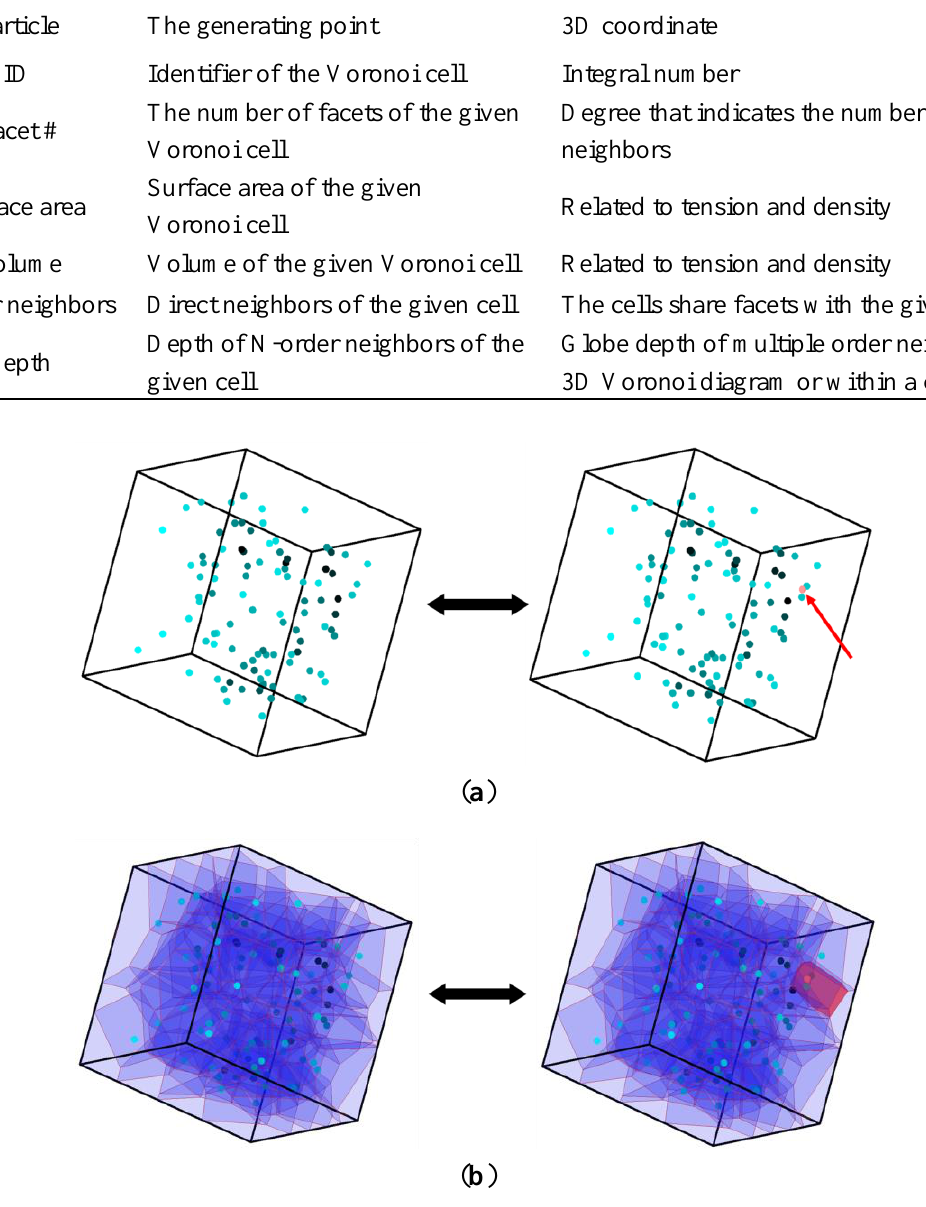
Figure 2. Spatial birth-and-death processes: ( a ) 3D points; ( b ) the corresponding 3D Voronoi